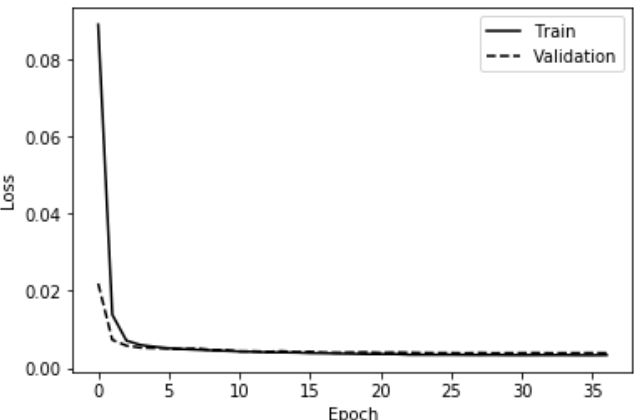
Figure 9. Training and validation loss of the deep ANN (multinomial classification). Table 10. Deep ANN-based anomaly detector’s traditional performance metrics recorded (multino- mial classification).